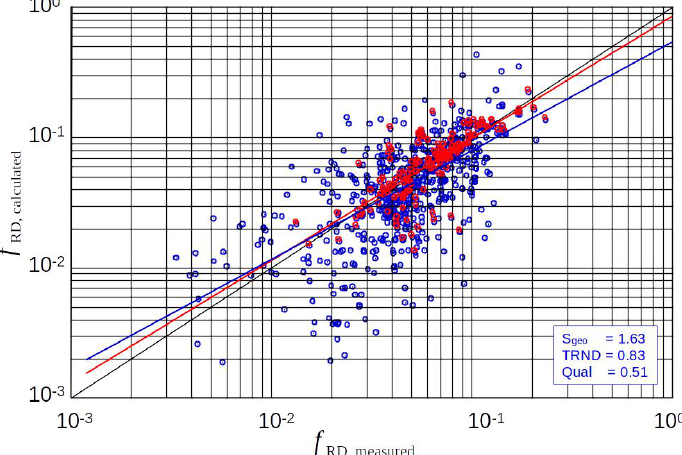
Figure 11. The new approach considering of the water coverage h / H (Equation (22). Red: ripple data only and blue: all